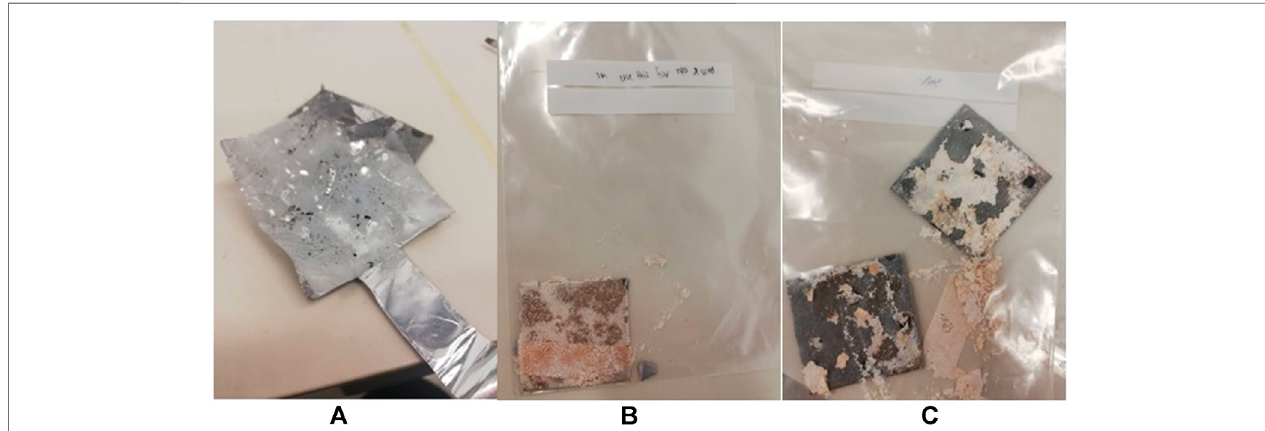
FIGURE 8 | Images of aluminum anode after more than 2 hours of discharging with 1 M (A) , 2M (B) , and 3M (C) of KOH concentration respectively.